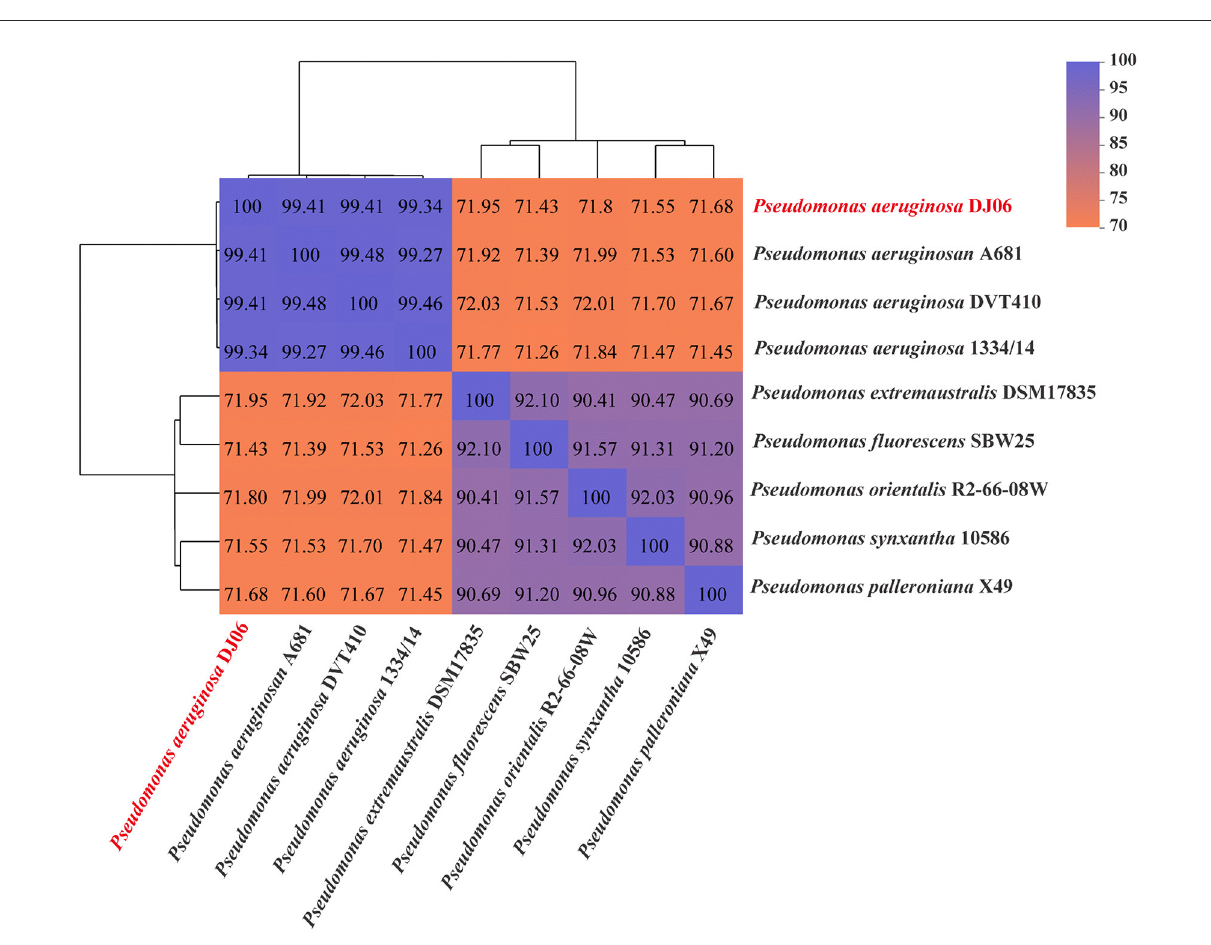
FIGURE3 Phylogenetic analysis of Pseudomonas aeruginosa DJ06 genome based on